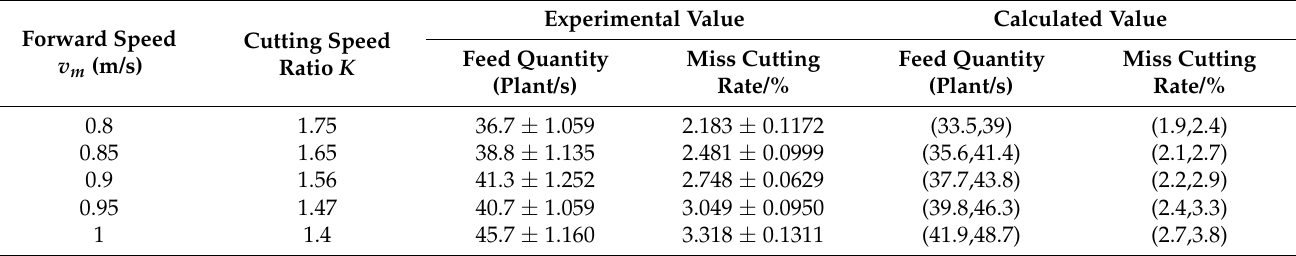
Table 9. Results of ramie field harvest.